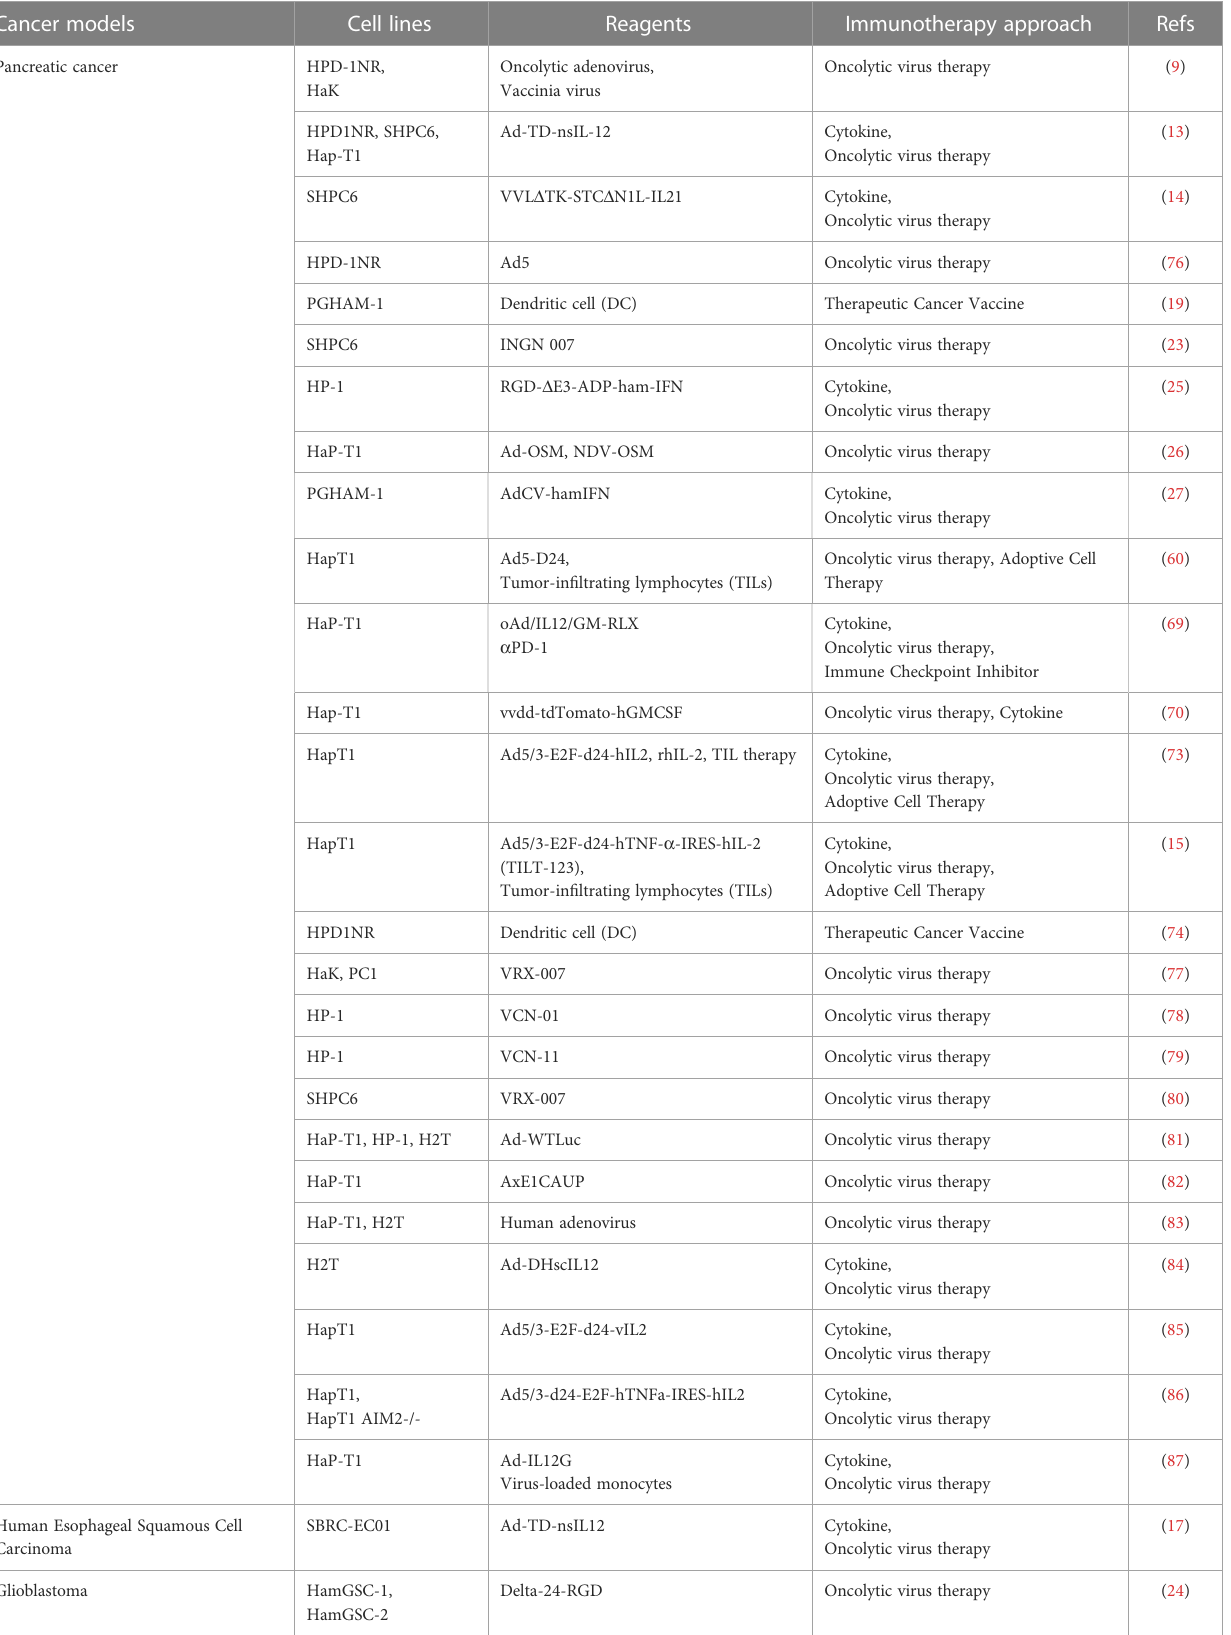
TABLE 1 The Syrian Hamster Models in Cancer